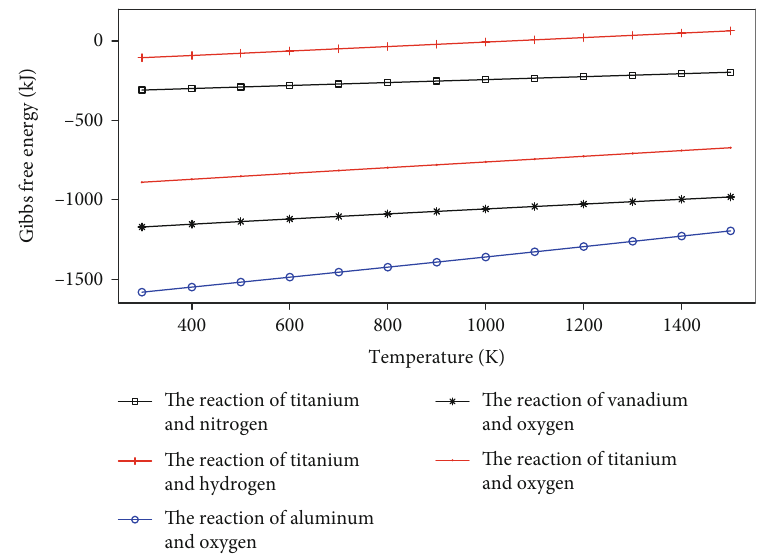
Figure 9: Gibbs free energy curves.